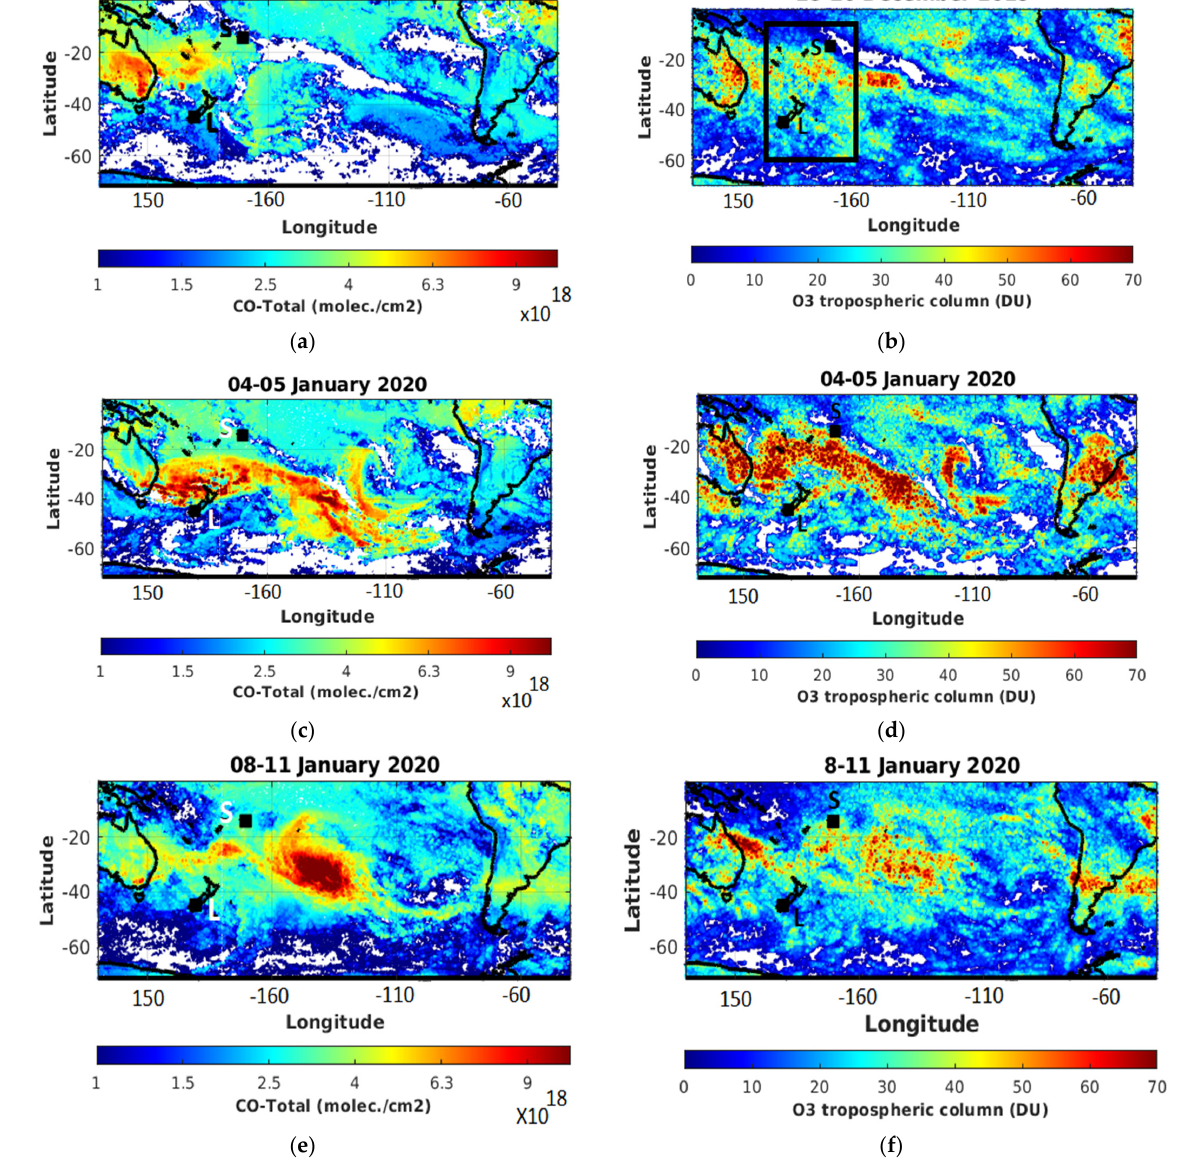
Figure 7. Time-averaged map of (left panel) total column of CO and (right panel) tropospheric ozone column obtained from IASI observations averaged over three successive periods, i.e., ( a , b ) on 18–20 December 2019, ( c , d ) on 4–5 January and ( e , f ) on 8–11 January. The location of the Samoa and Lauder sites are indicated by black boxes and the abbreviation sites (S for Samoa and L for Lauder).